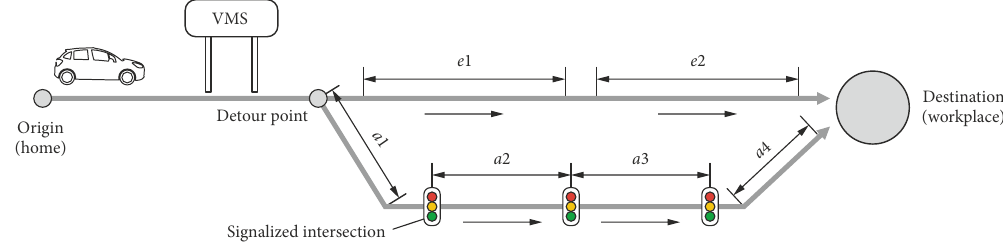
Figure 4. Network layout Table 5. Attributes and their